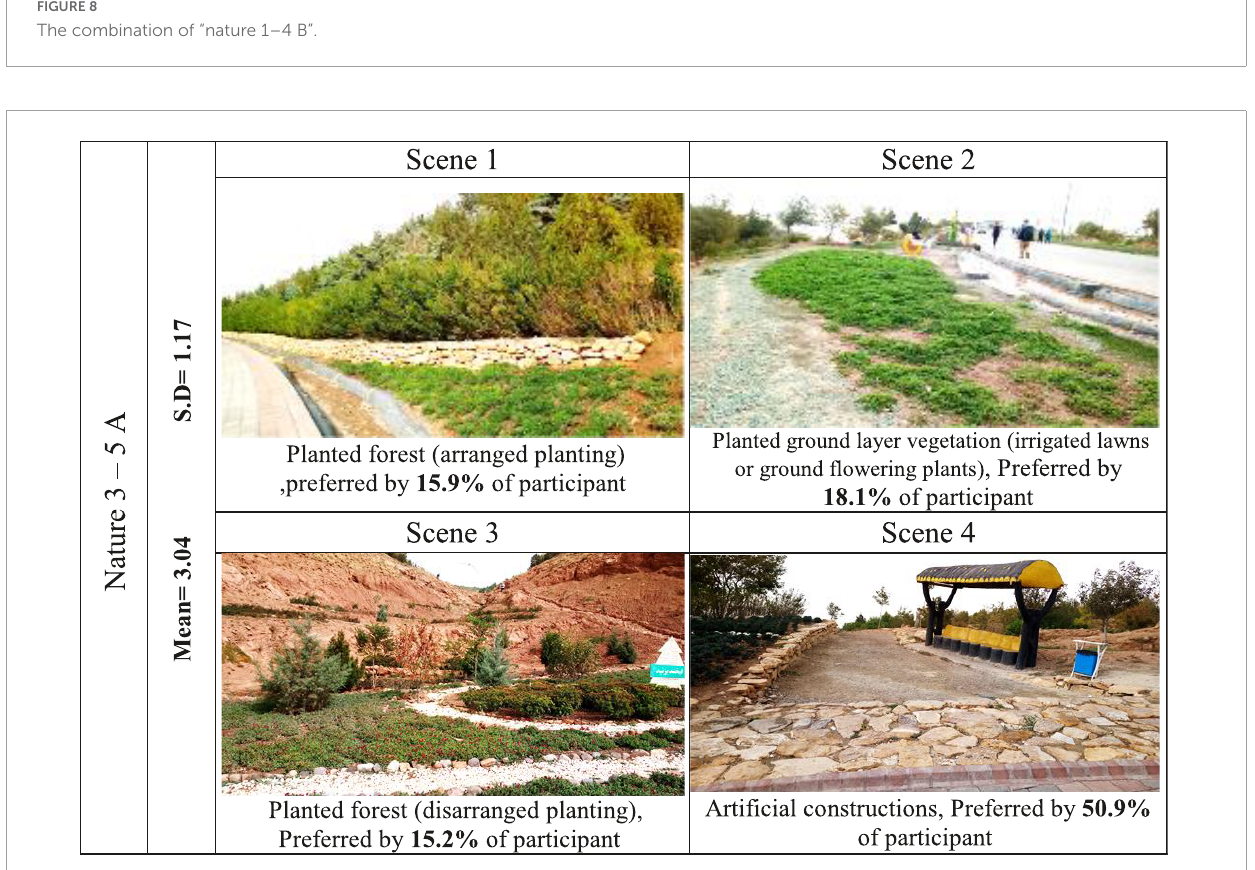
FIGURE9 The combination of “nature 3–5